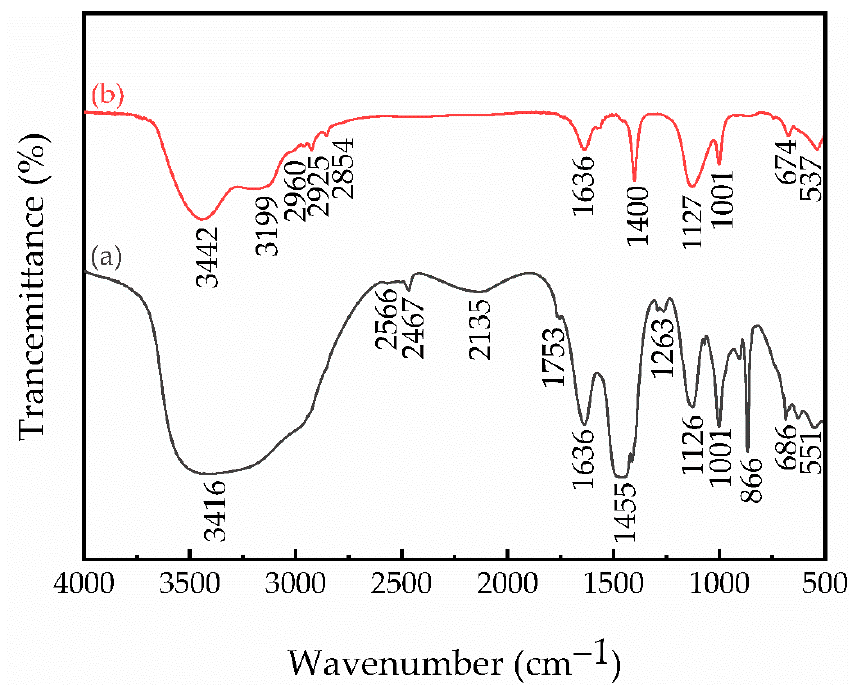
Figure 4. FTIR spectra of ( a ) sodium sulfide and ( b ) ammonium sulfide.